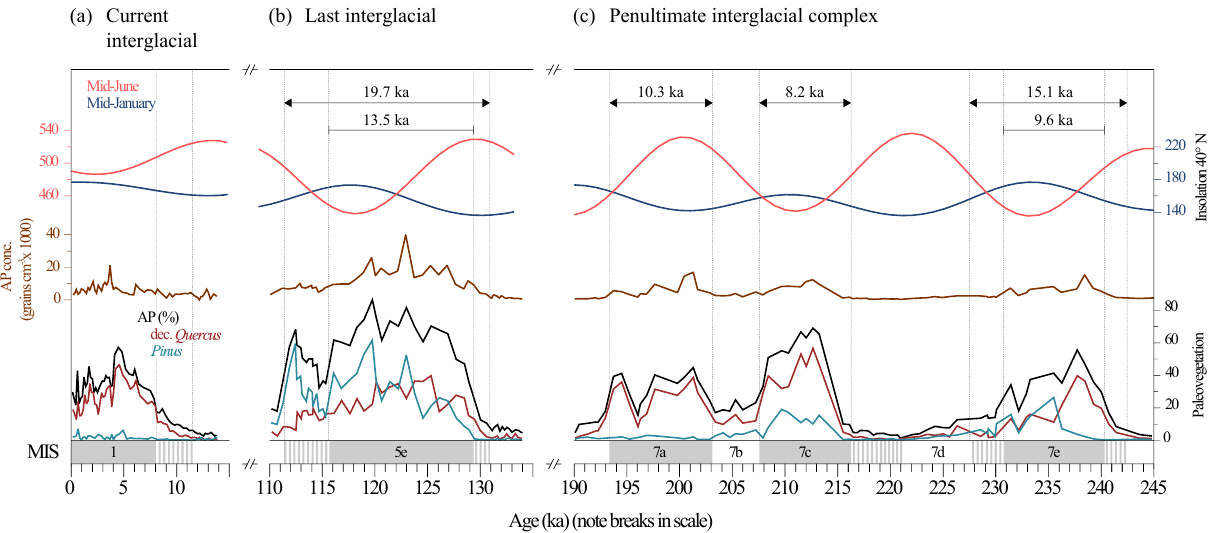
Figure 4. Comparison of (a) current interglacial (MIS 1; Litt et al., 2009) with (b) last interglacial (MIS 5e; Pickarski et al., 2015a) and (c) penultimate interglacial complex (MIS 7; this study) at Lake Van. Shown are the insolation values (40 ◦ N, Wm − 2 ) after Berger (1978) and Berger et al. (2007), the Lake Van arboreal pollen (AP) concentration (grainscm − 3 , brown line), and the Lake Van paleovegetation (AP, deciduous Quercus , and Pinus in %). The gray boxes mark each steppe-forest interval. Marine isotope stage (MIS; Lisiecki and Raymo, 2004) and the length of each interglacial (MIS 5e, 7a, 7c, and 7e; black arrows) are